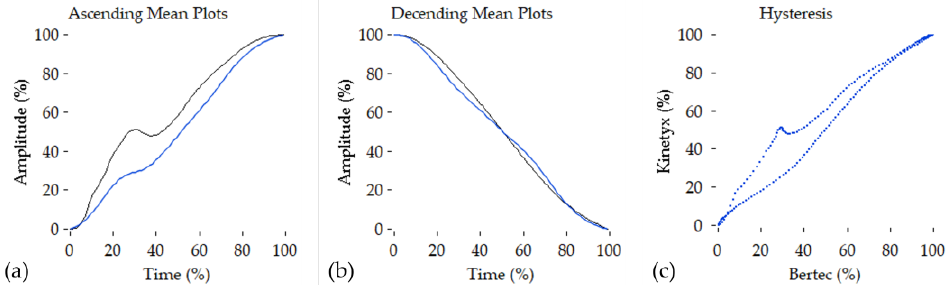
Figure 4. Mean loading plots from the running data. ( a ) shows the mean normalized loading data from the ascending part of the signal from the Bertec (black) and SI (blue); ( b ) shows the mean normalized loading data from the descending part of the signal from the Bertec (black) and SI (blue); ( c ) shows the mean hysteresis plot of SI vs. Bertec.